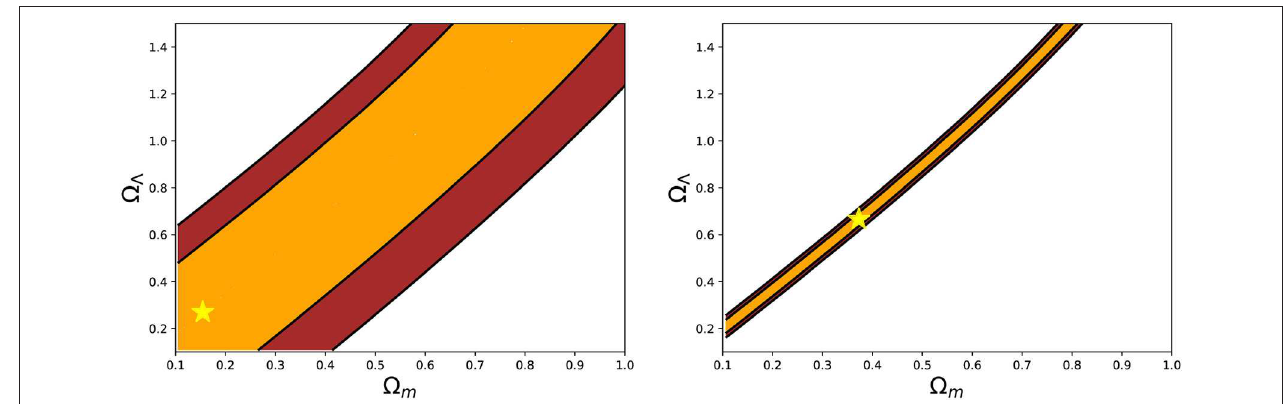
FIGURE 7 | Effect of the time-delay uncertainty on constraining cosmological parameters for the quasar CTS 30.10. The color-coded regions represent the result of χ 2 fitting with the star denoting the minimum and the orange and the brown areas stand for 1 σ and 2 σ uncertainties, respectively. (Left) Time-delay of 562 (Right) Time-delay of 564 2 days as determined by the JAVELIN ±